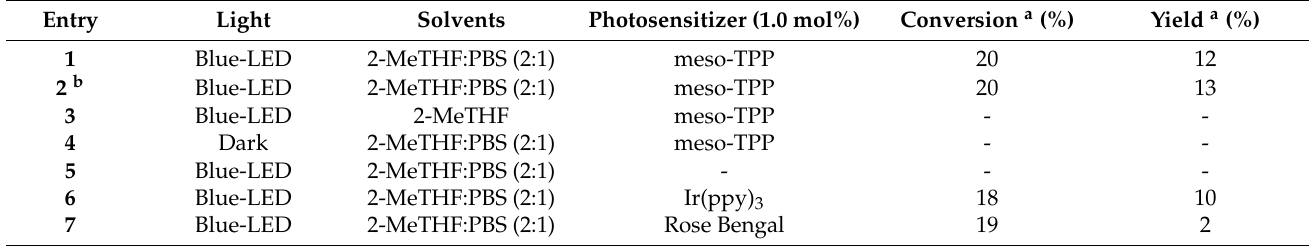
Table 1. Blue LED-driven two-liquid-phase photo-oxygenation of 17 α -ethinylestradiol 1b to hydro- peroxide 2b .